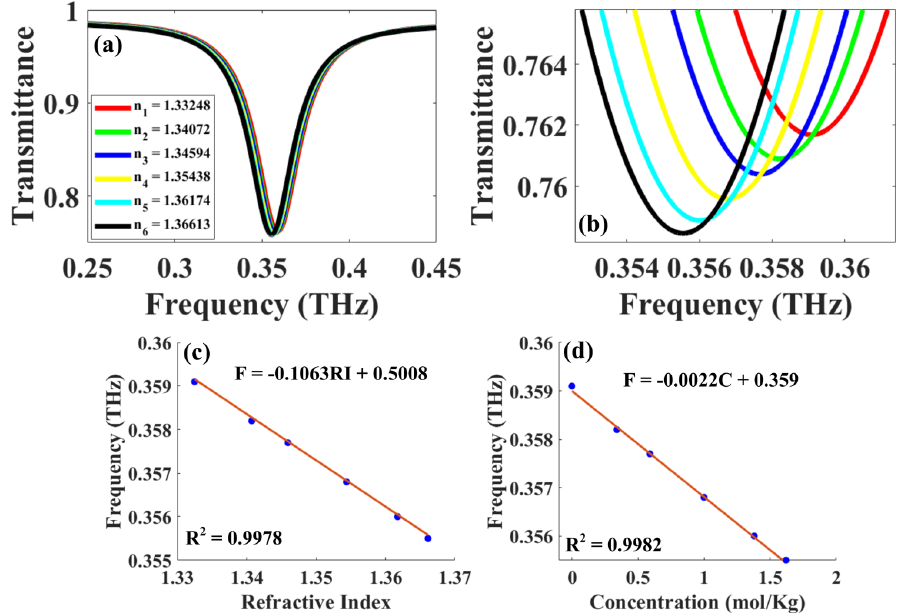
Figure 5. Detection of Mg 2+ contaminated water by employing developed graphene-metasurface- inspired sensor, ( a ) transmittance getting affected by increasing the concentration of Mg 2+ in water from 0 mol/kg to 1.62 mol/kg, ( b ) transmittance response moving left and transmittance drop increment is observed as the Mg 2+ contamination in water is increased, and as a result of the RI of water solution also increase from 1.32348 to 1.36613, ( c ) the curve fitting for RI vs. resonance frequency at which the transmittance drop is achieved for that particular RI, a linear fit with R 2 score of 0.9978 is obtained, ( d ) the curve fitting for concentration vs. resonance frequency at which the transmittance drop is achieved for that particular concentration, a linear fit with R 2 score of 0.9982 is obtained.